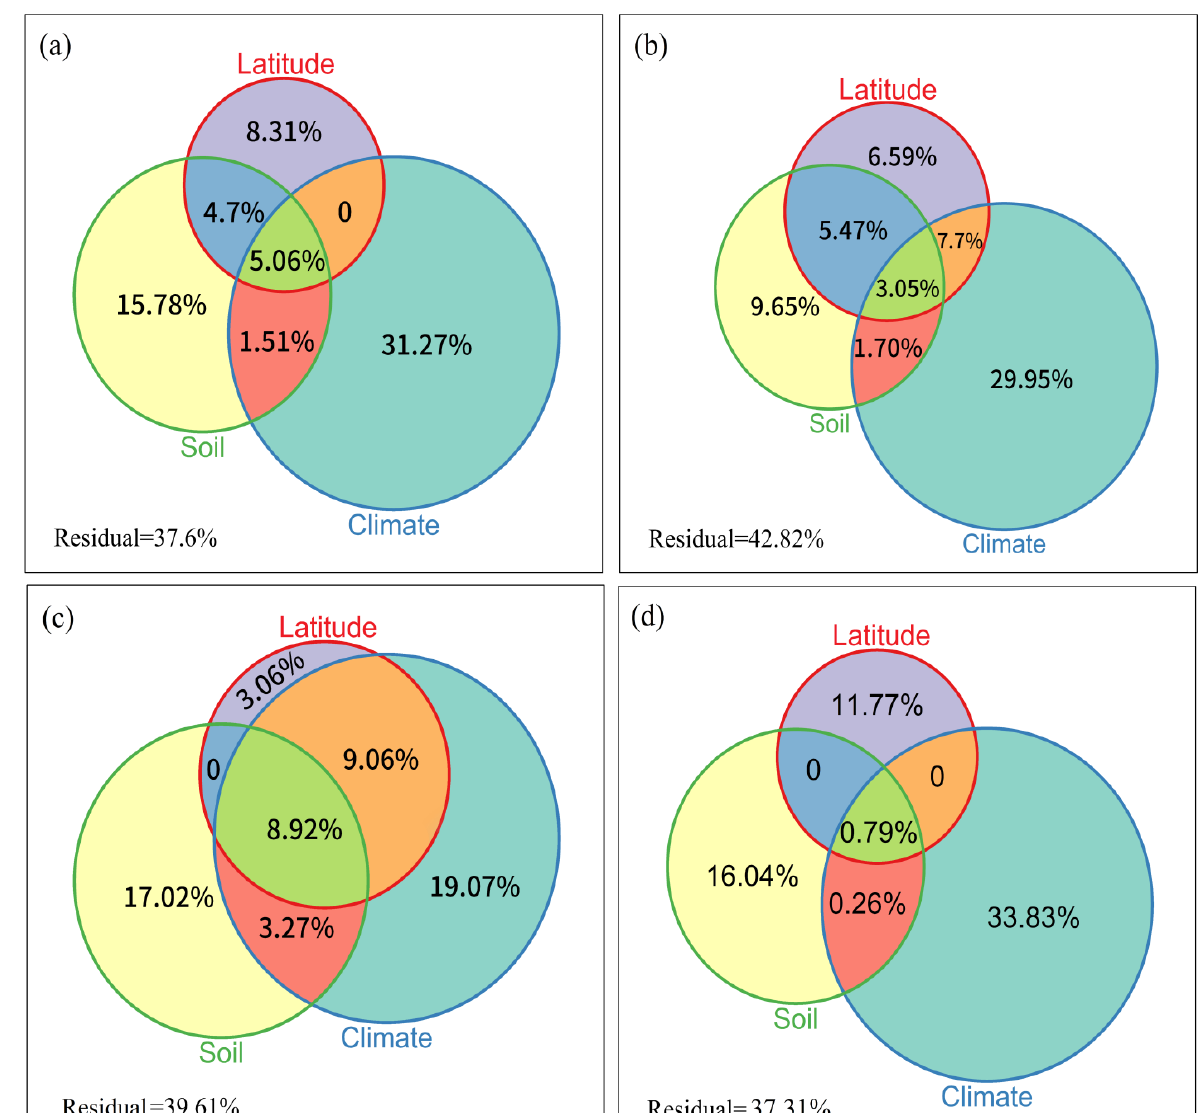
Figure 7. Percent of the effects of climate, soil and latitude on the overall ( a ), phytophagous ( b ), predatory ( c ) and saprophagous ( d ) fauna orders ’ compositions in East Asia.